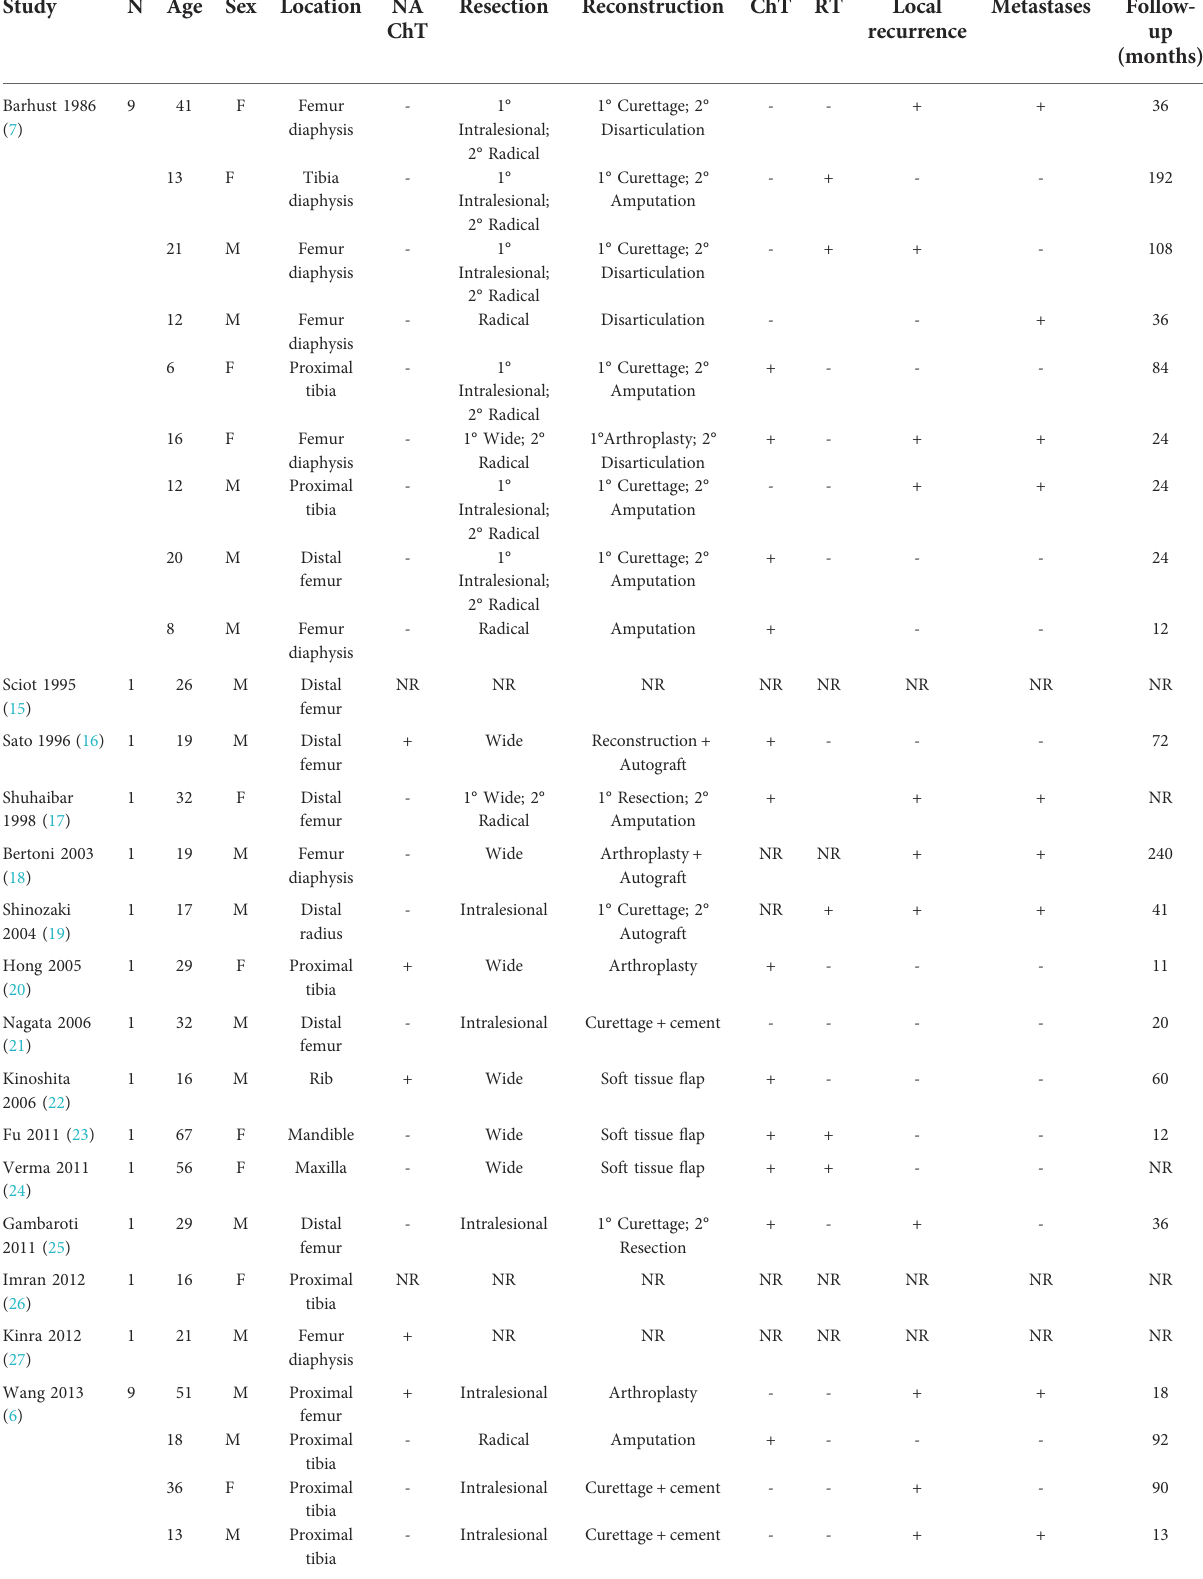
TABLE 1 Outline of the cases of giant cell-rich osteosarcoma published in the literature. Study N Age Sex